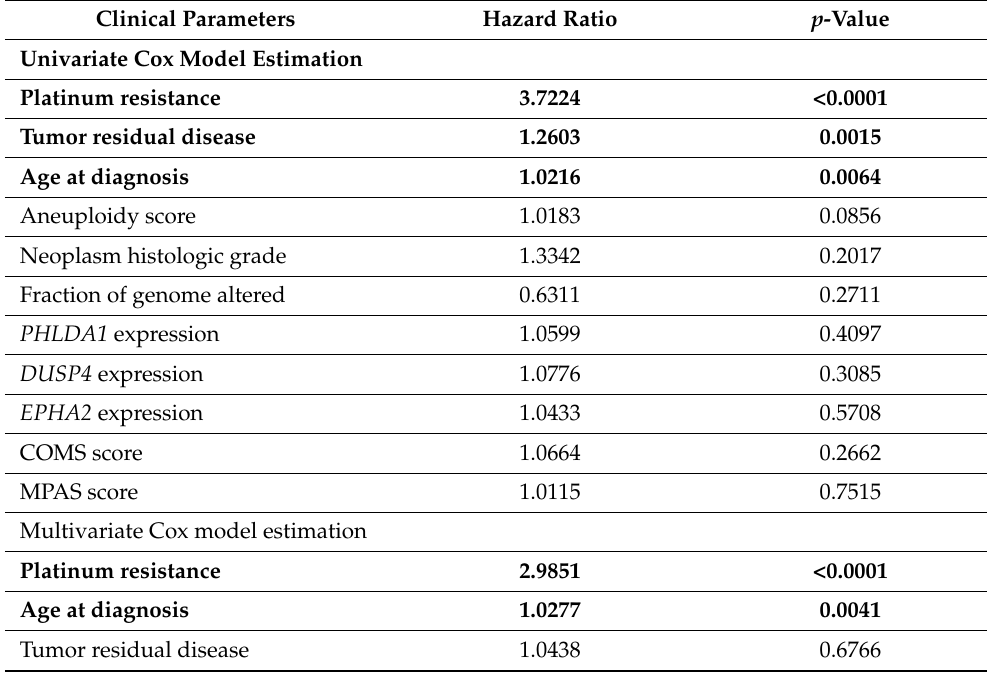
Table 3. Cox proportional hazards analysis of associations between clinical parameters of HGSOC cases, COMS and MPAS gene expression levels, and overall survival of HGSOC patients from TCGA datasets. Hazard ratios higher than “1” indicate that the clinical parameter of interest is associated with poor survival, while hazard ratios less than “1” define parameter of interest as a factor of favorable prognosis. Clinical parameters emphasized with bold text display statistically significant associations with patients’